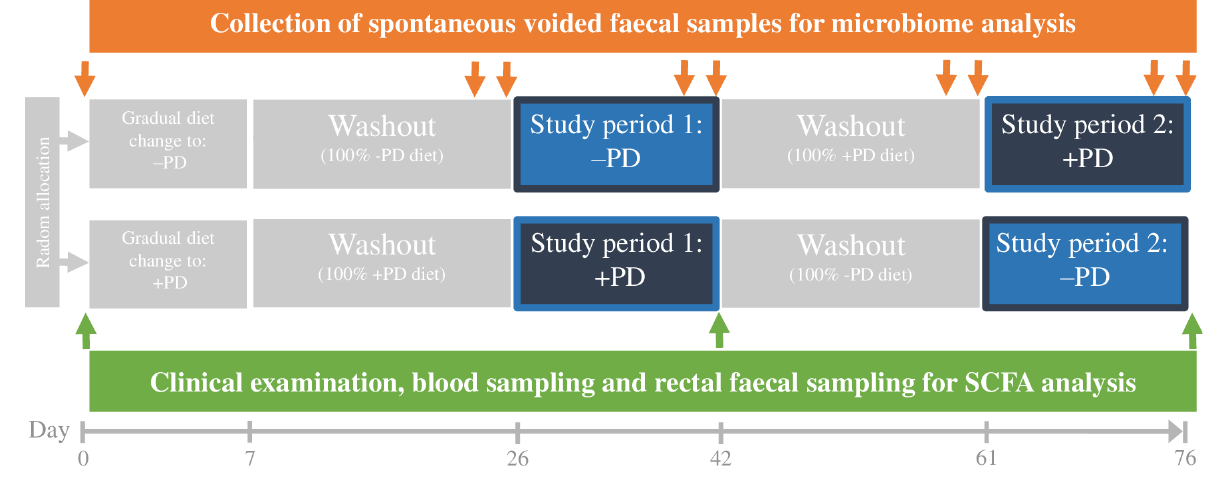
Figure 1. Study design. The study was a prospective randomized double-blinded crossover study composed of two study periods of each 16 days, both with a preceding washout period of 19 days. Included dogs (n = 11) were exclusively fed the same nutritionally balanced commercial canine diet with (+PD) or without ( − PD) Enterococcus faecium NCIMB 10415·10 9 CFU/kg incorporated. Orange arrows indicate time points for collection of spontaneously voided faecal sampling for microbiome analysis (day 0, 24, 25, 40, 41, 59, 60, 75 and 76). Green arrows indicate time points for collection of blood samples for serum triglyceride, cholesterol, cobalamin, and folate concentrations as well as rectal faecal sampling for short chain fatty acids (SCFA) analysis (day 0, 42 and 76).